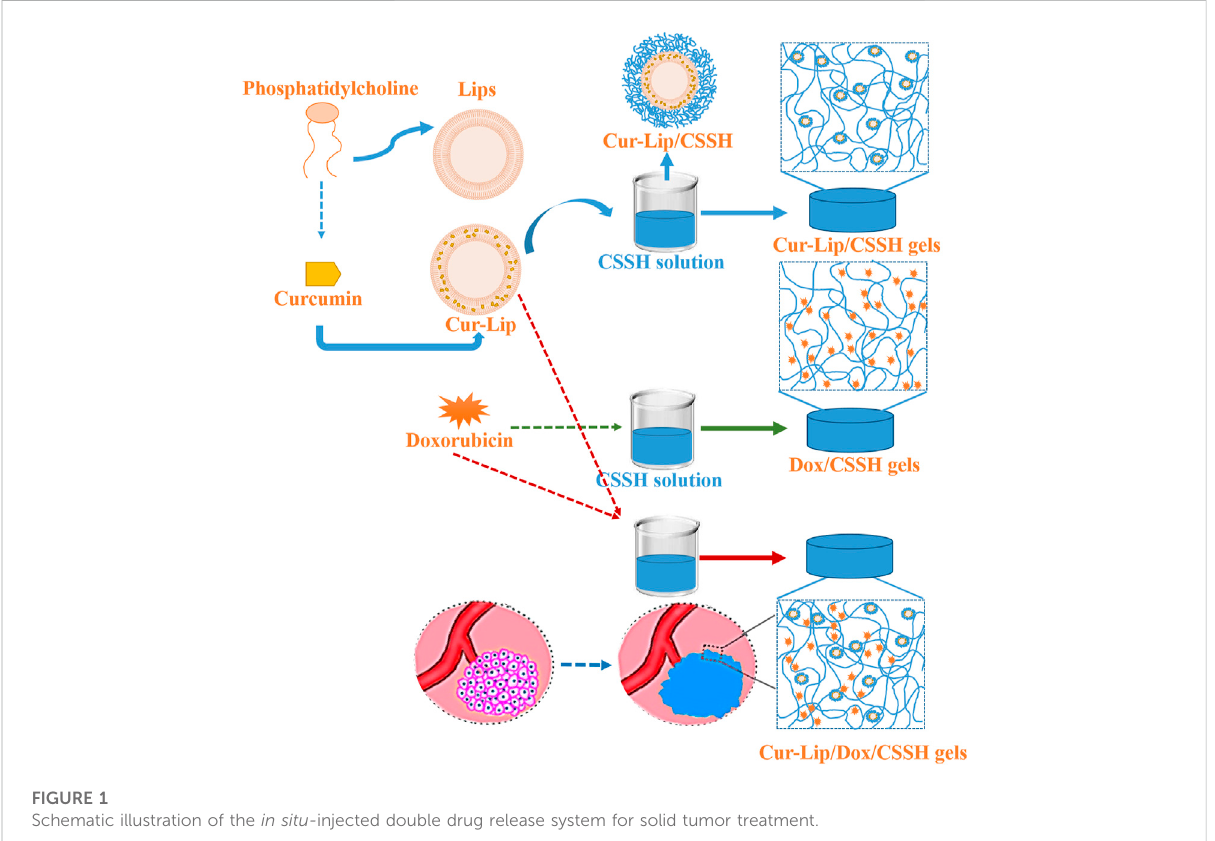
FIGURE 1 Schematic illustration of the in situ- injected double drug release system for solid tumor treatment.